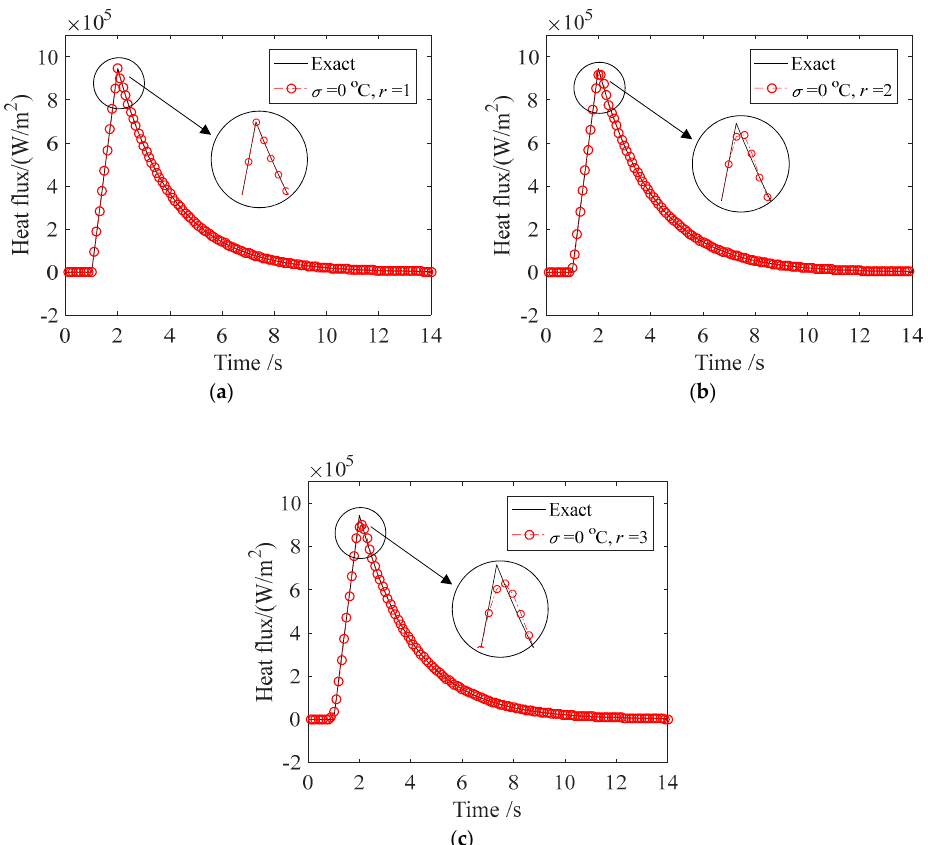
Figure 6. Inverse solution of heat flux when no measurement noise is present: ( a ) r = 1; ( b ) r = 2; and ( c ) r = 3. Table 2. Error analysis for heat flux inversion when no measurement noise is present.